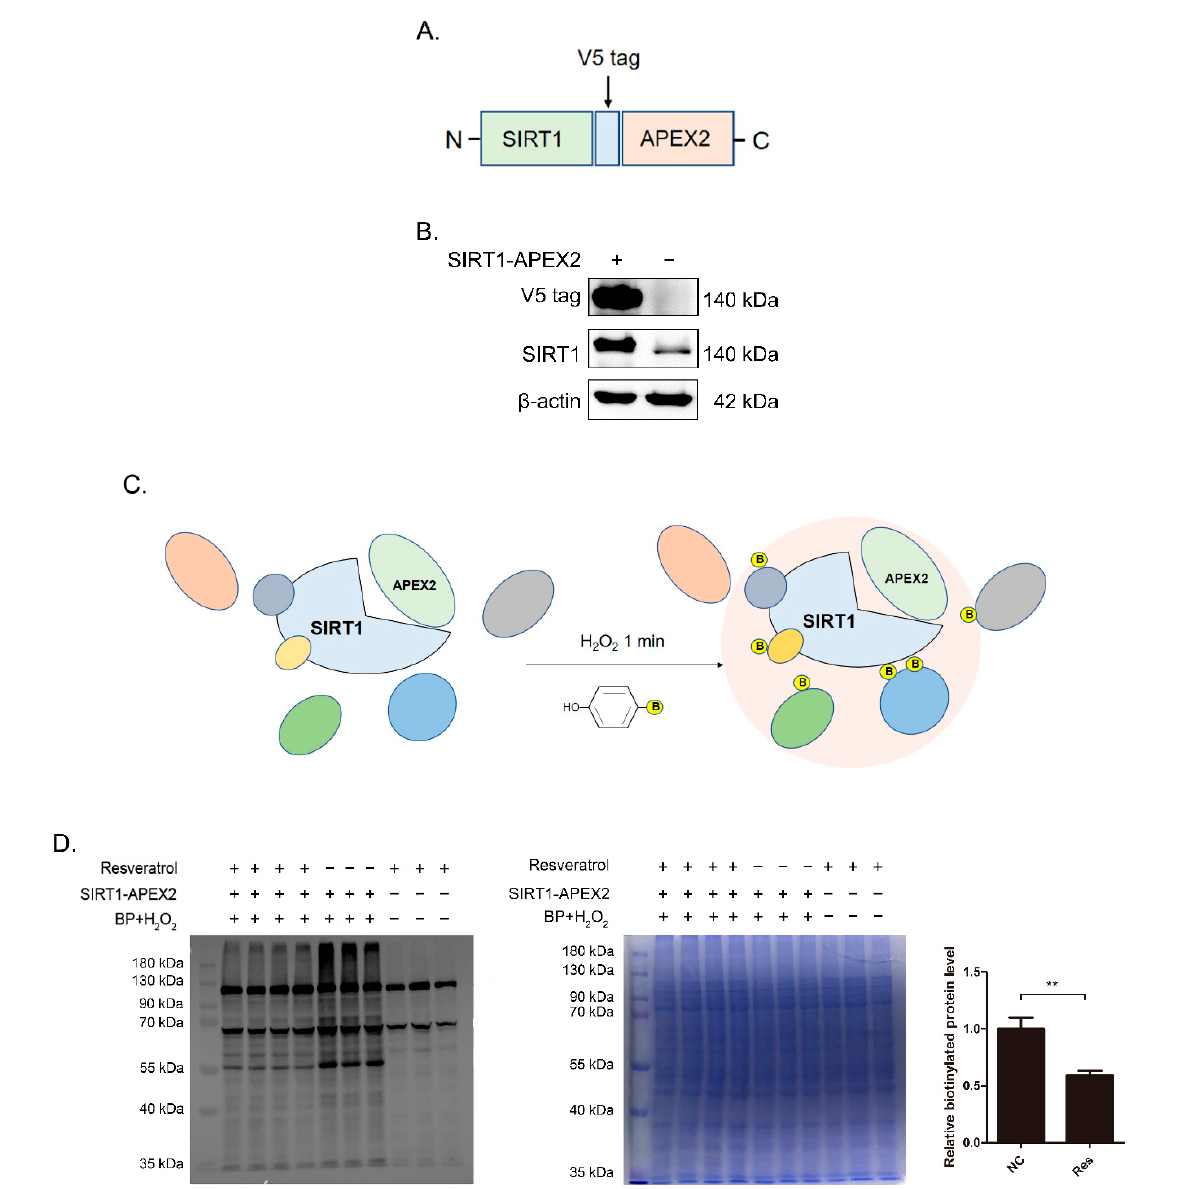
Figure 1. Expression and activity characterization of SIRT1-APEX2 recombinant protein. HEK 293T cells were transfected with SIRT1-APEX2 (>50% transfection efficiency) and labeled. Cells were then lysed, separated by SDS-PAGE and analyzed by blotting with streptavidin-horseradish peroxidase. ( A ) A schematic drawing of the SIRT1-APEX2 constructs. SIRT1 gene (light green) was ligated to 5 ′ end of APEX2 (pink) with a V5 tag (blue). ( B ) Analysis of recombinant protein expression by SIRT1-APEX2 in HEK 293T cells. ( C ) Scheme showing APEX2-catalyzed biotinylation. Live cells are incubated with biotin-phenol (BP) probe (yellow B = biotin) for 30 min and then treated for 1 min with 1 mM H 2 O 2 to initiate biotinylation. APEX2 catalyzes the one-electron oxidation of biotin-phenol into a biotin-phenoxyl radical, which covalently tags proximal endogenous proteins. ( D ) Characterization of APEX2 mediated biotinylation of endogenous proteins by streptavidin blotting. Negative controls in which resveratrol, BP and H 2 O 2 or SIRT1-APEX2 were omitted. The β -actin and Coomassie brilliant blue staining were used as loading controls. The pooled data were shown here as mean ± SEM, and the significant differences from control cells were shown in p < 0.01 (**). The independent experiments were repeated at least three